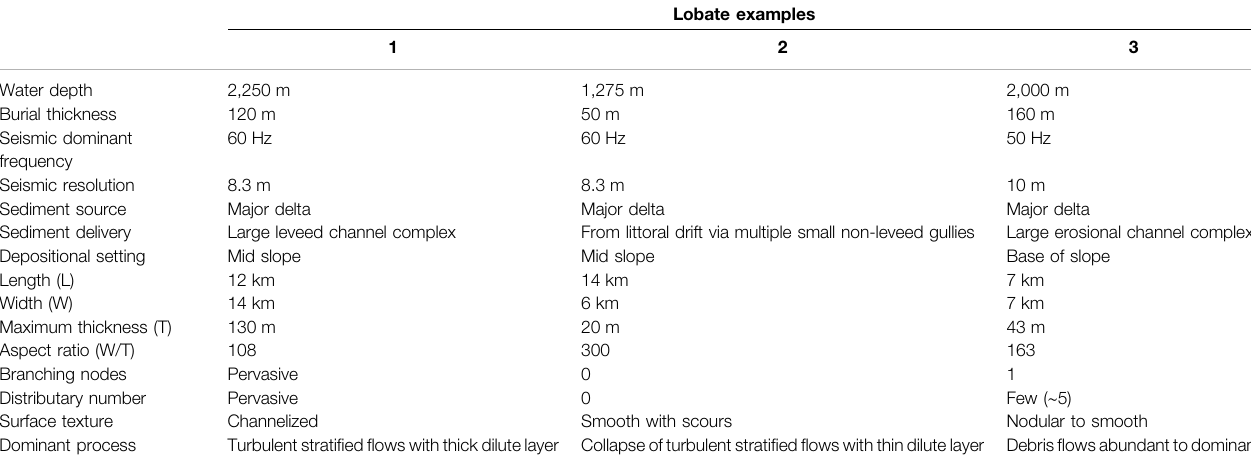
TABLE 1 | Tabular summary of contextual data and observations associated with each of the three discussed lobate